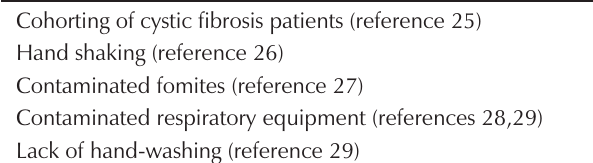
Factors associated with nosocomial transmission of Burkholderia cepacia Cohorting of cystic fibrosis patients (reference 25)